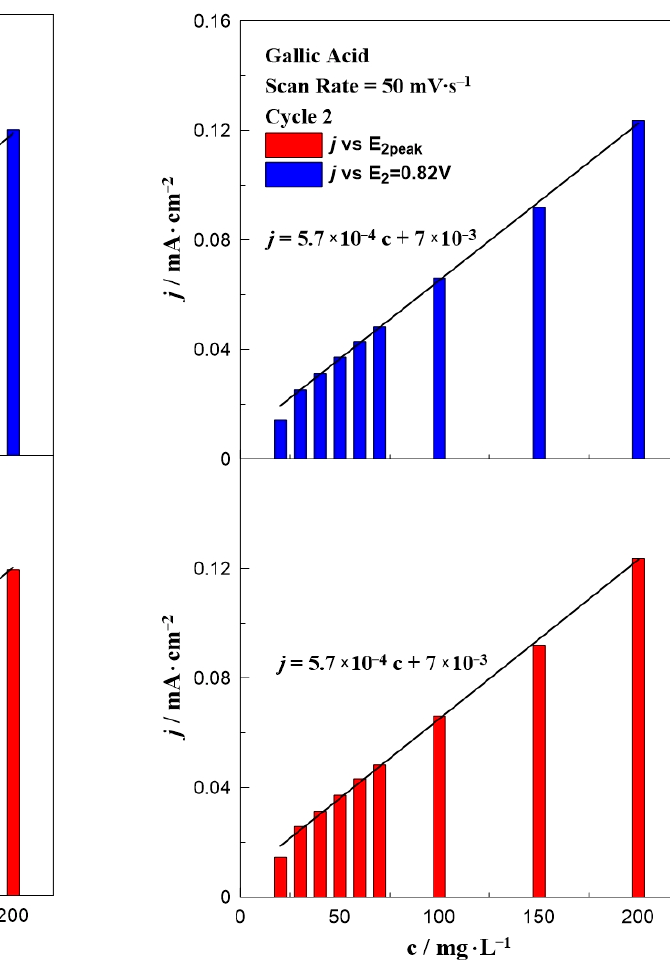
Figure 5. Effect of gallic acid concentration on the current density value at E 1 and E 1, peak ( left ) and E 2 and E 2, peak ( right ) at a constant scan rate of 50 mV ∙ s − 1 .